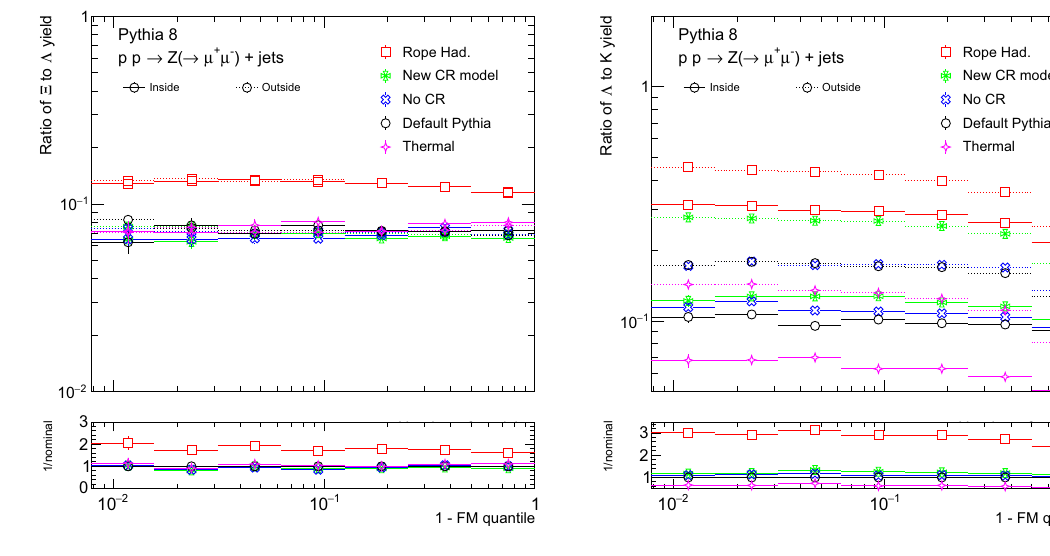
Fig. 5 Strangeness (left) and baryon (right) enhancement using the (cid:8) - to- (cid:9) (left) and (cid:9) -to-Kaon (right) ratios as a function of the FM quantile for the various models described in Sect. 2.1 outside of jets. Low values